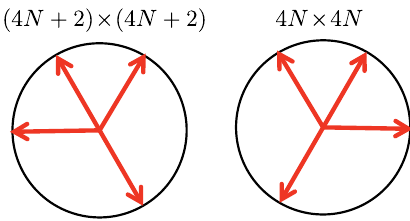
FIG. 15. Symmetry quantum numbers for C 6 rotation, calcu- lated analytically (Appendix C) for the fourfold topologically degenerate ground-state sector of the SCCL phase on different lattice sizes. C 6 eigenvalues are plotted on the unit circle in complex plane. The sets of eigenvalues differ by overall phase between different system sizes ( N is integer and X × Y labels number of unit cells along a 1 , a 2 ), although all systems are topologically a